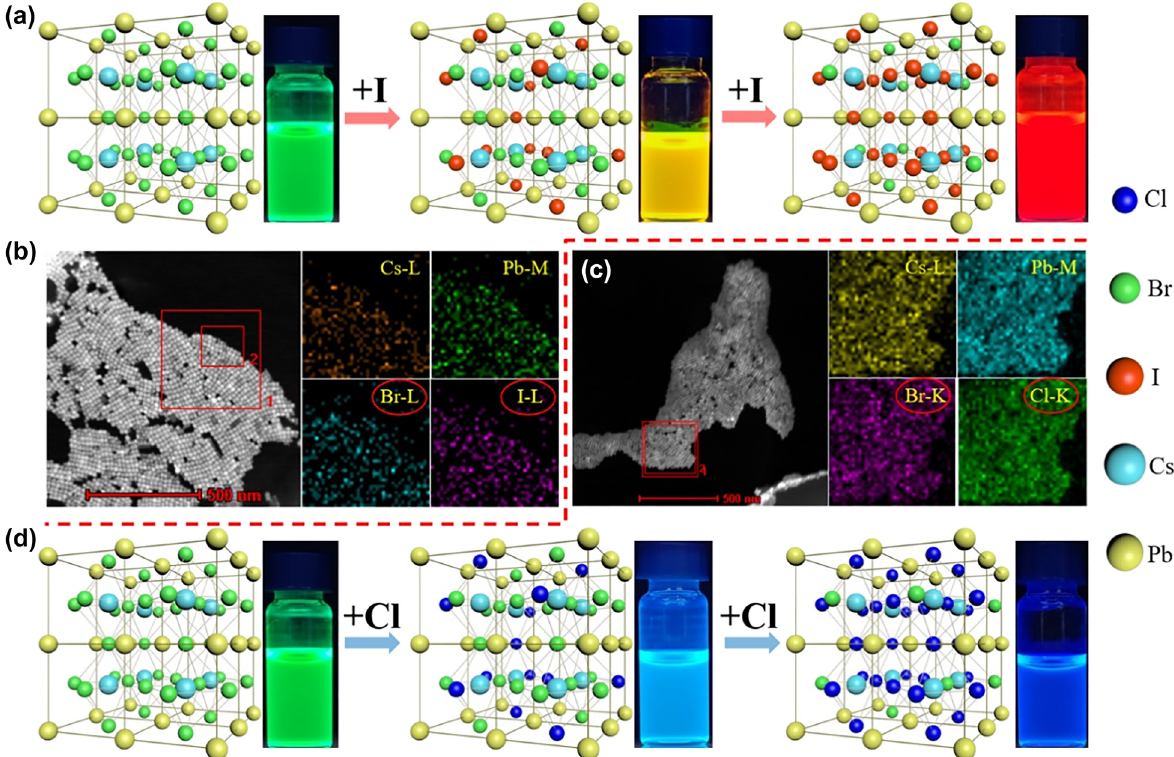
Figure 2: The crystal structures and composition changes of PQDs during the ion-exchange reaction. (a) Type-I anion exchange resin and (d) Type-Cl anion exchange resin participating in the reaction. Elemental mapping image of ion-exchange reaction products (b) CsPbBr x I 3 − x and (c) CsPbBr x Cl 3 − x